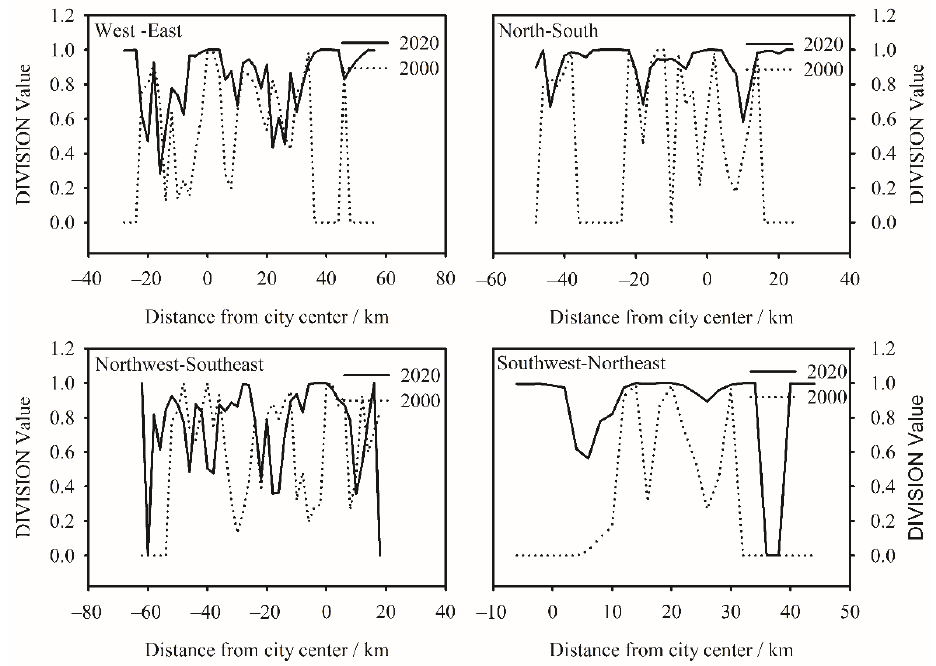
Figure 5. The temporal gradient change in farmland fragmentation in 8